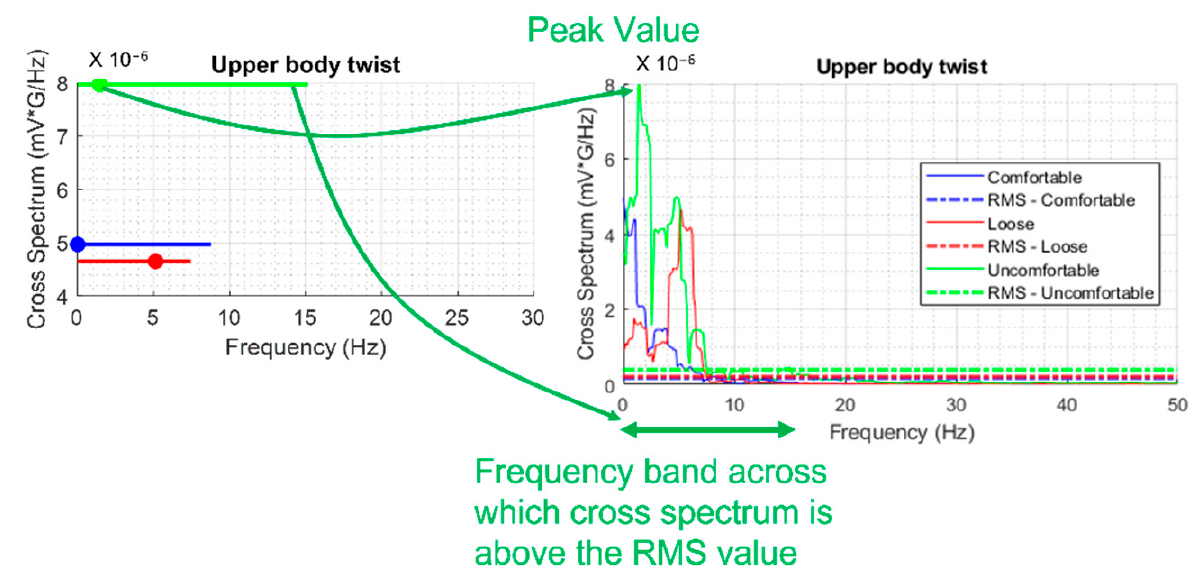
Figure 7. Method of creating charts for assessment of CSC across subjects for each activity.